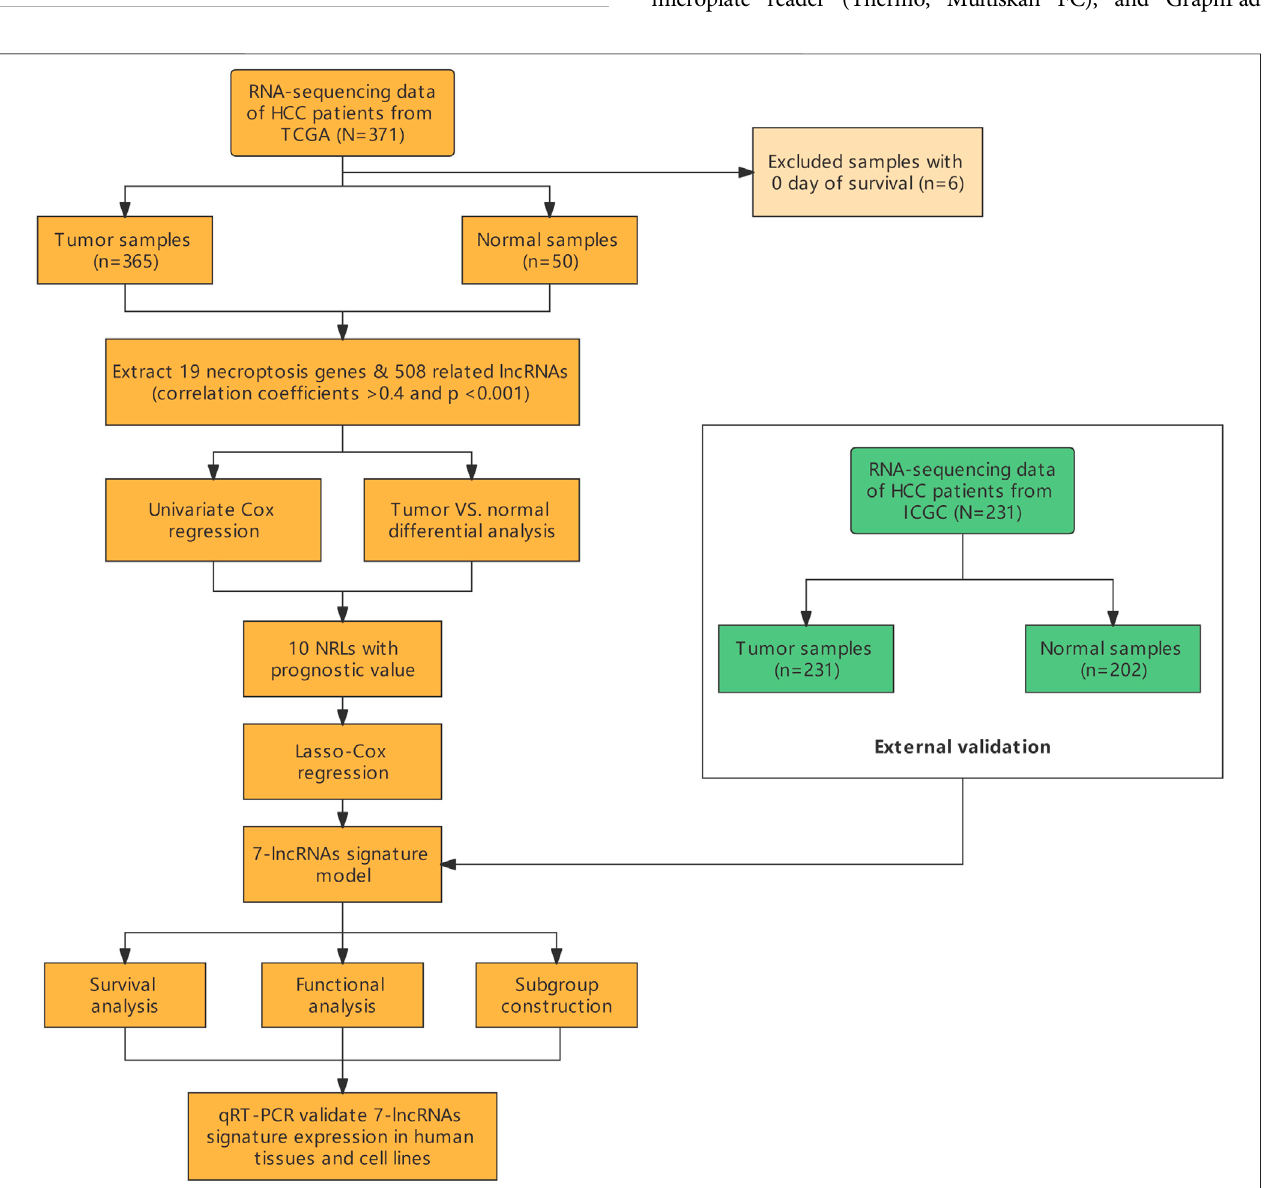
FIGURE 1 | Flow chart of the study.